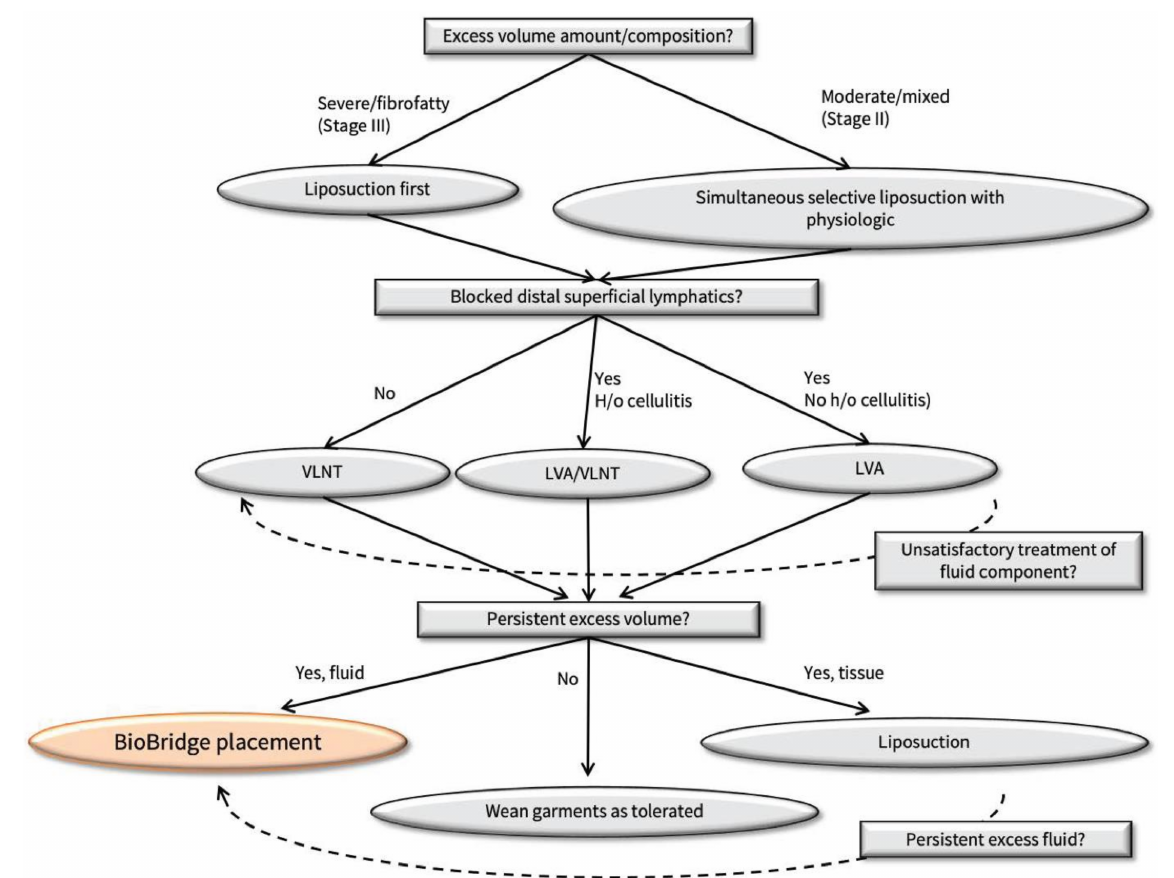
Figure 1. Treatment algorithm for Stage II-III